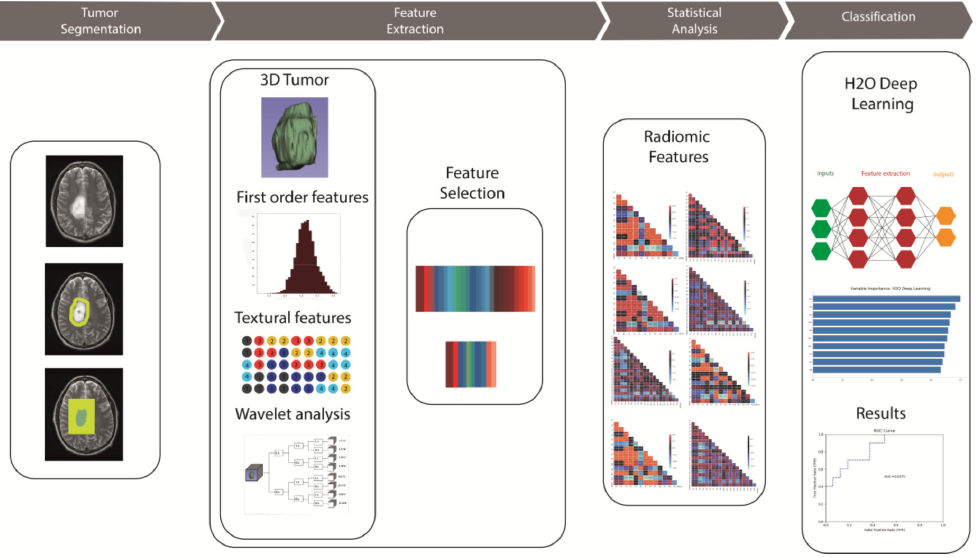
Figure 1. The block diagram of the proposed system.